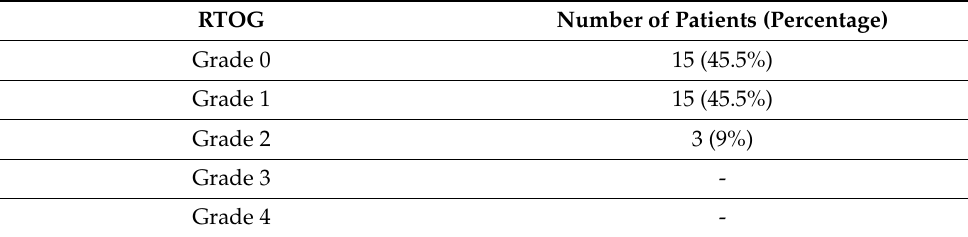
Table 7. Characteristics of the toxicity of radiotherapy and the brachytherapy procedure. RTOG— toxicity criteria of the Radiation Therapy Oncology